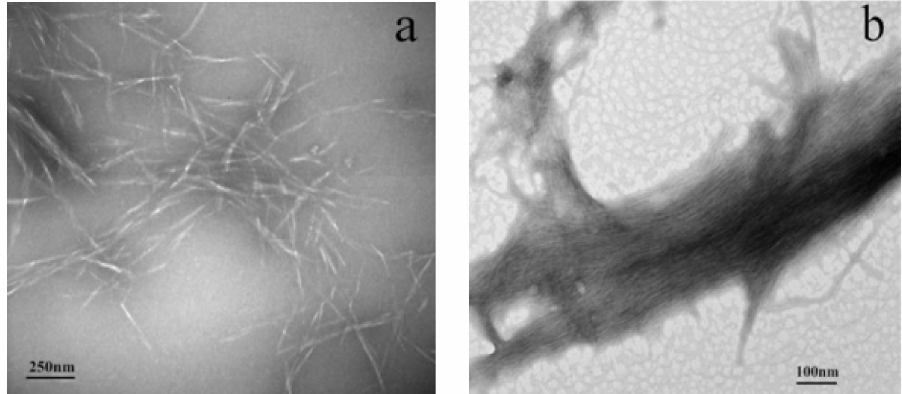
Figure 4. TEM micrograph of NCC ( a ) and NCC-UPy ( b